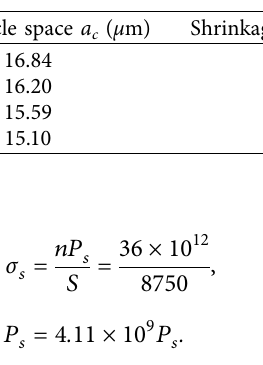
Figure 9: The process development of water-air-solid phases in loess: (a) totally dry state; (b) saturated state; (c) isolated air pore state; (d) water-air-solid interaction state. Table 3: The parameters in different experimental